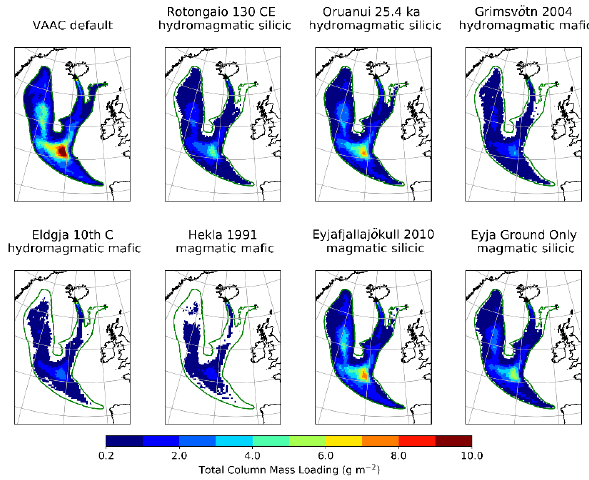
Figure 10. Total column mass loadings for 8 May 2010 00:00 UTC using a range of input PSDs. The extent of the plume simulated using the VAAC default PSD is shown as a green outline on each plot. Atmosphere 2020 , 11 , x FOR PEER REVIEW Residual ash mass loading was calculated by subtracting the modelled ash concentrations simulated using the VAAC default PSD from the modelled concentrations when the input PSD is varied. Figure 11 shows the results for total column mass loadings on 6 May 2010 12:00 UTC and 8 May 2010 00:00 UTC, for the coarsest (Hekla 1991) and finest (Eyjafjallajökull 2010) PSDs. Values for the remaining PSDs are shown in Figures S5 and S6. Peak values of total column mass loading are up to 5-fold greater using the VAAC default PSD than for all other PSDs, with the most extreme differences observed when comparing the VAAC default to the coarsest PSDs (Eldgja and Hekla) (Figure 10).